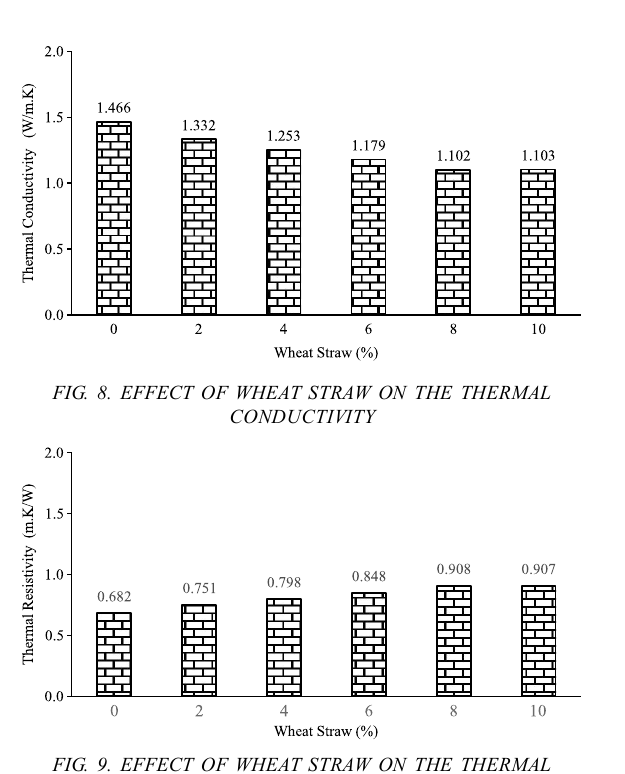
and thermal resistivity are shown in Figs. 8-9 respectively.